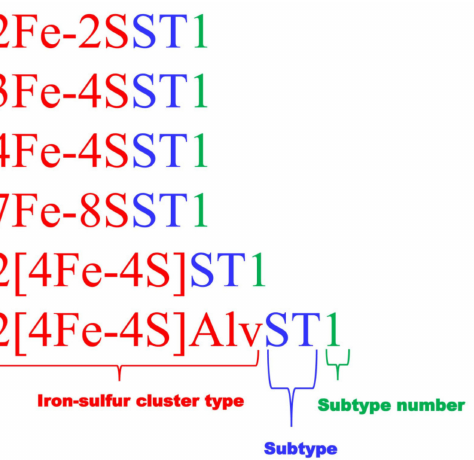
Figure 1. Ferredoxin nomenclature based on the spacing between the cysteine amino acids of the Fe-S cluster binding motif. Ferredoxins start with their Fe-S cluster type, followed by their ST indicating subtype and then the numeral indicating its subtype number in that type. Proteins grouped into different subtypes have the same characteristic spacing between the cysteine amino acids of the Fe-S cluster binding